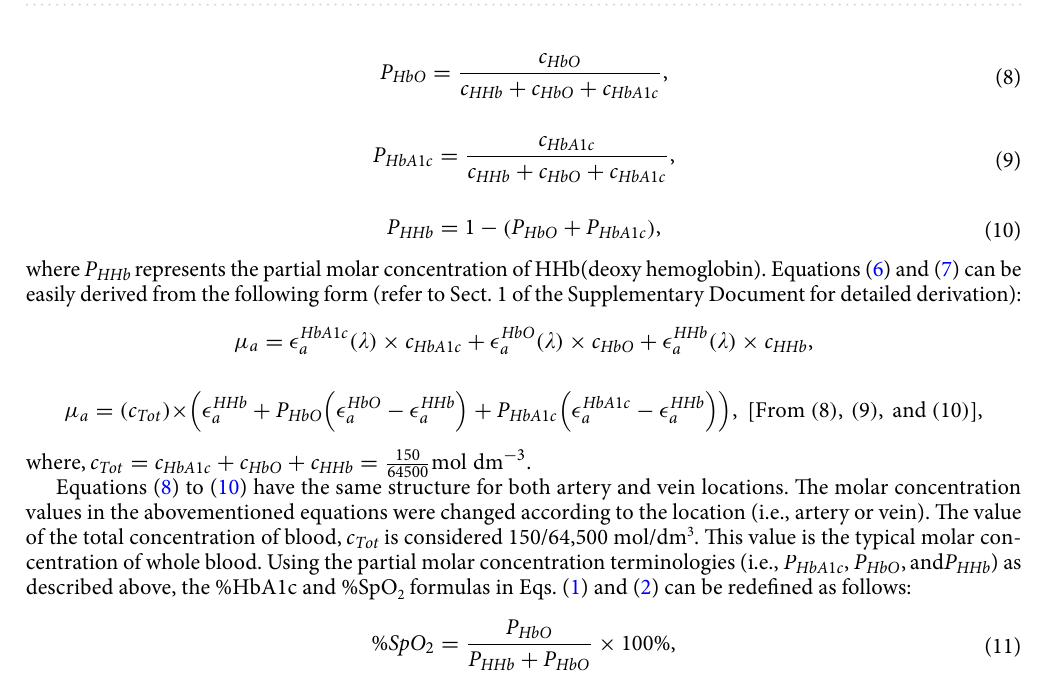
Figure 2. Fractional volume composition of the whole-finger